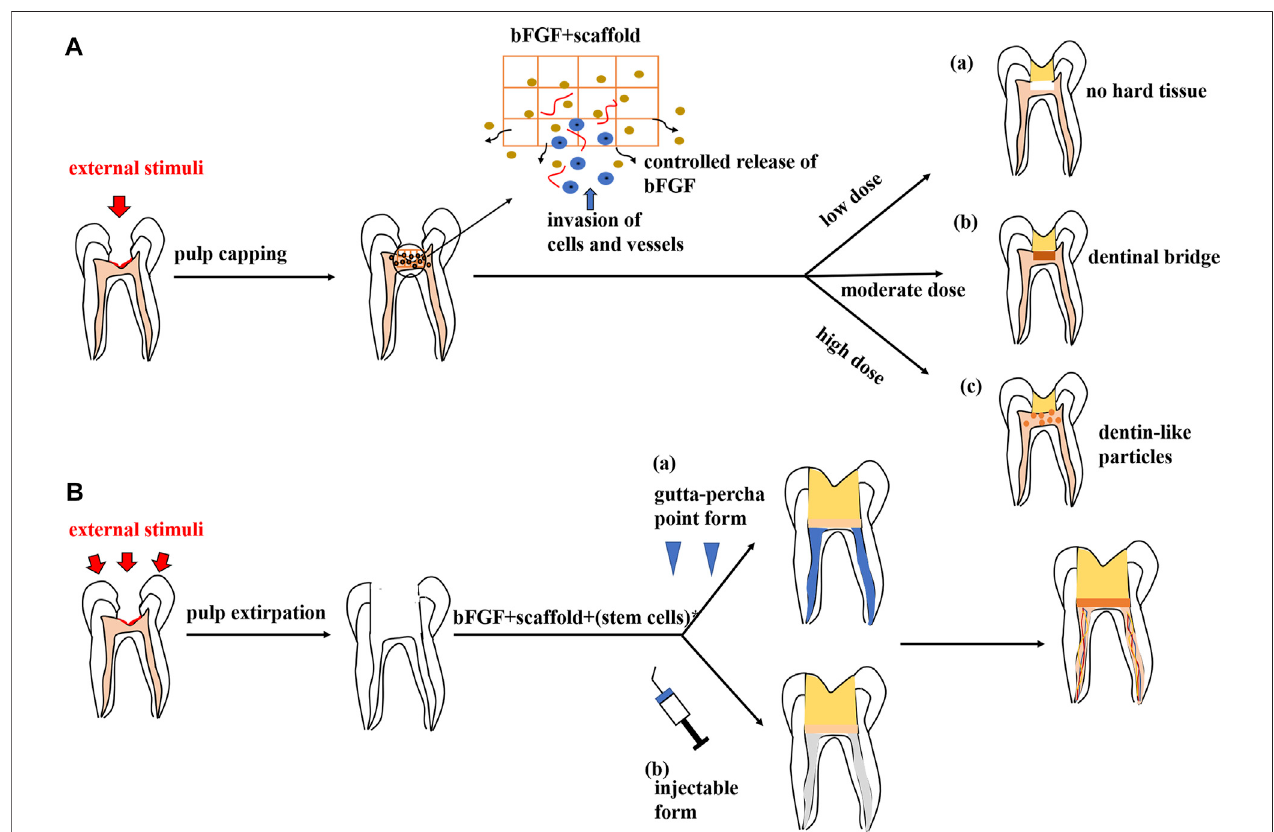
FIGURE3| PotentialtherapeuticstrategiesofthebFGF inregenerative endodontic therapy. (A) Pulp repair. ThebFGFcouldbeprepared asapulp-capping agent whencombinedwithacustomized scaffold.ThisdrugcarriersystemcouldprovidecontrolledreleaseofthebFGFandinducetheingrowth ofcellsand vessels,resulting inlocalpulpregenerationanddentineformation.Theoutcomesaredose-dependent:(a)lowdoseofthebFGF(0,0.05 mg/ml),nocalci fi edtissueformation;(b)moderate dose ofthebFGF(0.5 mg/ml), dentinal bridge – likestructure on thedentin defect surface; and(c) high dose ofthe bFGF(1.0,5.0 mg/ml), dentin-like particlesin the proliferating pulp. (B) Pulp regeneration. A speci fi c scaffold in the gutta-percha point or an injectable form loads the bFGF or the combinatory group of factors, with or without stem cells, which could be applied in pulp regeneration therapy, leading to pulp-like tissue formation in root canals.